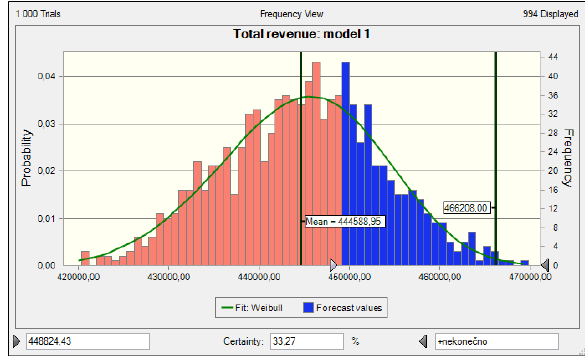
Figure 7: Forecast chart for total revenue per year: model